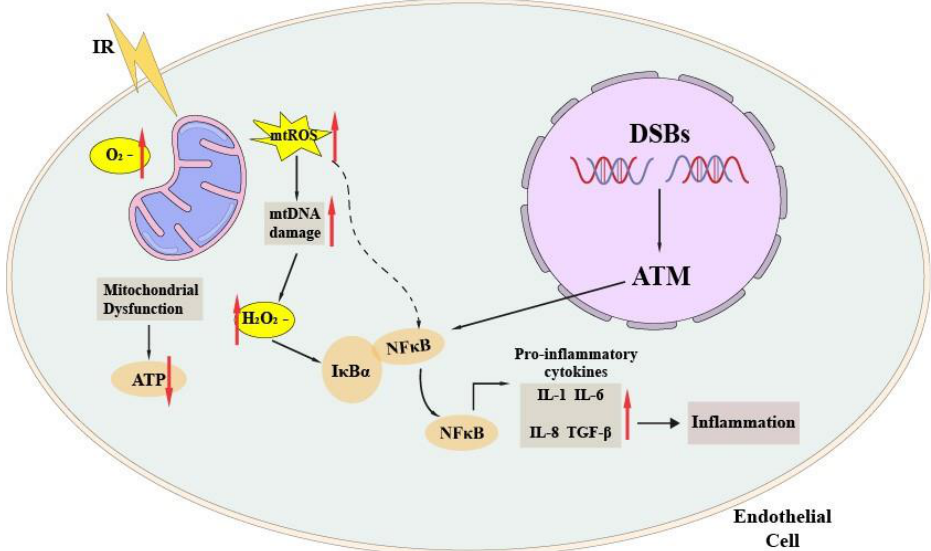
Figure 2. Radiation-induced inflammation in endothelial cells. IR exposure activation of redox-sensitive transcription factor NF- κB via DSB and oxidative stress. The resulting inflammation leads to the production and secretion of pro-inflammatory cytokines.